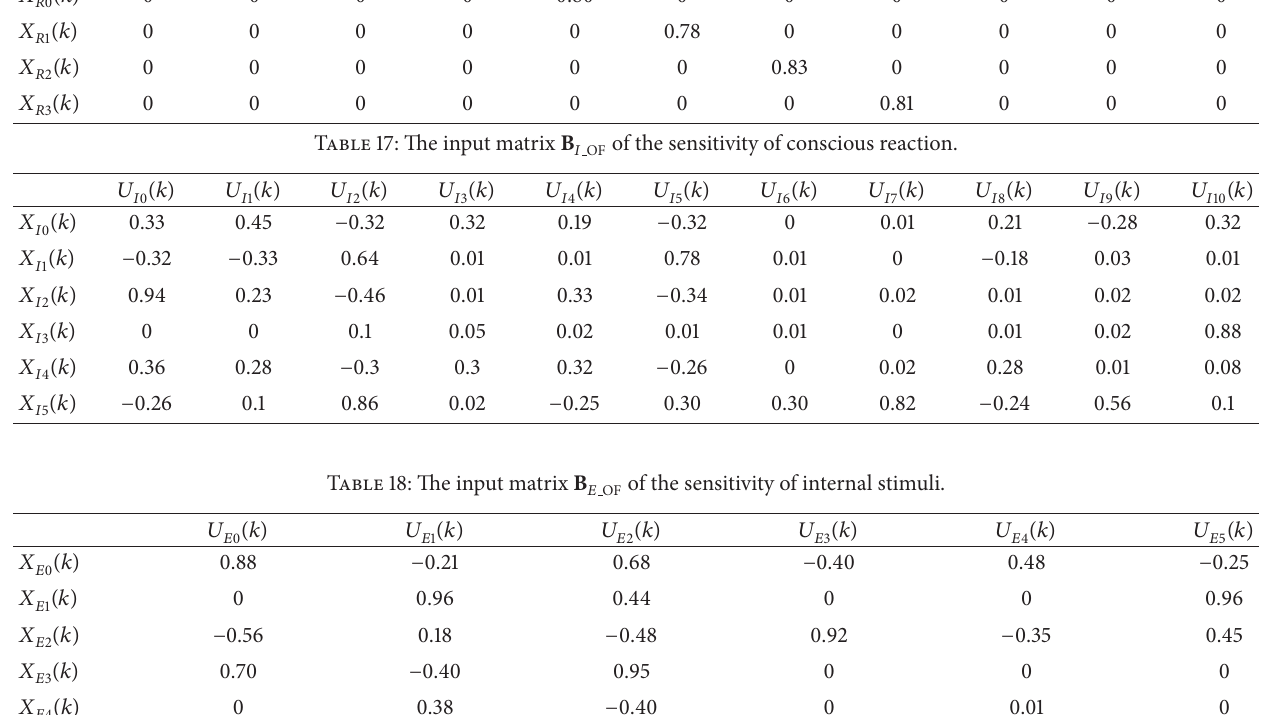
of the sensitivity of unconscious reaction. OF